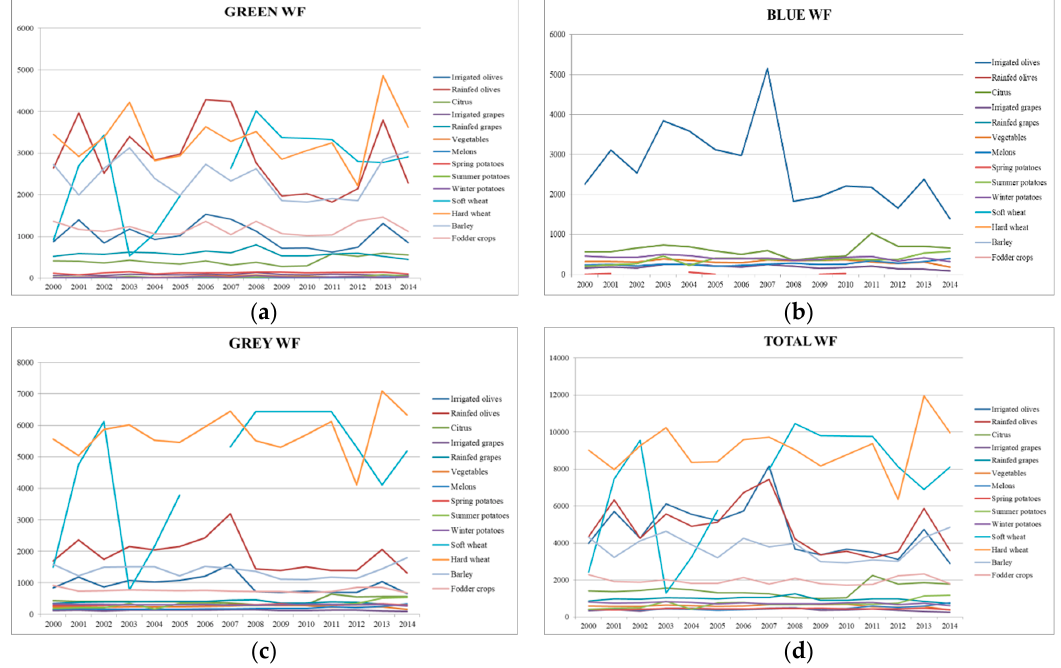
Figure 11. WF (m 3 t − 1 ) for the period 2000–2014: ( a ) green WF; ( b ) blue WF; ( c ) gray WF; and ( d ) total WF.